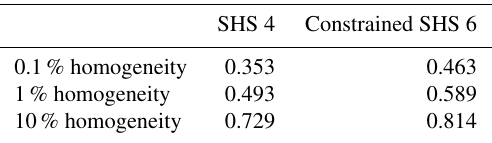
Table 6. Homogeneity comparison between the SHS 4 prototype and the constrained extended SHS 6.